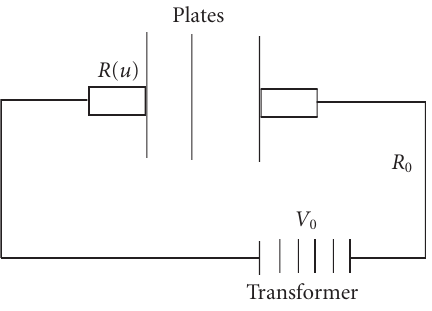
Figure 2.1. The spot welding setting.